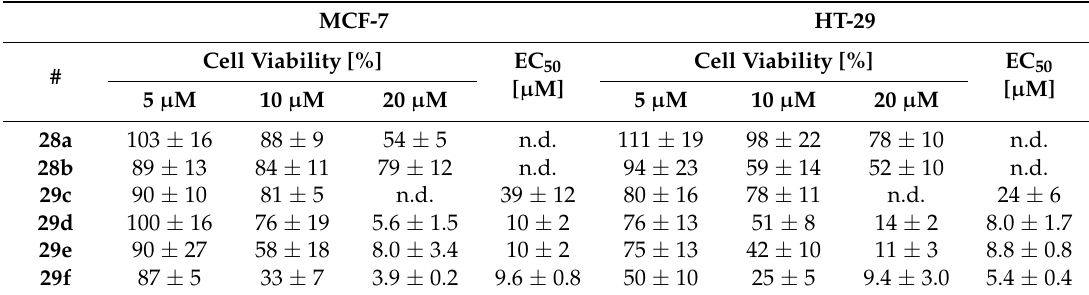
Table 2. EC 50 values and cell viability of MCF-7 and HT-29 cells after treatment with compounds 28a , b and 29c – f . Results are presented as mean ± SD from experiments performed in triplicate ( n = 3).